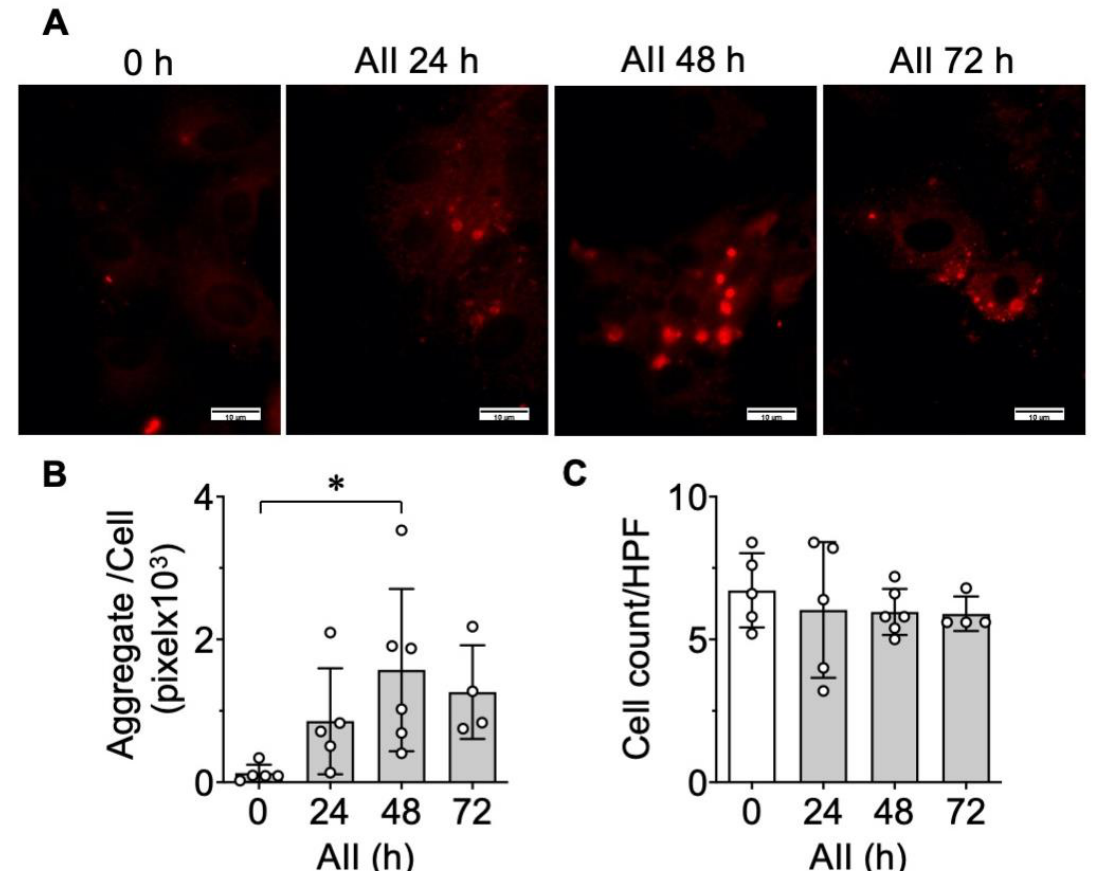
Figure 1. Induction of protein aggregation by angiotensin II (AngII) in vascular smooth muscle cell (VSMC). ( A – C ) The cultured rat aortic VSMCs were serum starved for 48 h. The VSMCs were stimulated with 100 nM AngII (AII) for 24–72 h as indicated. Representative Proteostat staining images are shown ( A ). The scale bar indicates 10 µ m. The aggregate positive area per cell ( B ) and total attached cells ( C ) in high power field (HPF) were evaluated with ImageJ software. The bars in the graphs show the mean ± SD from three independent experiments with single or duplicated groups. * indicates p < 0.05.